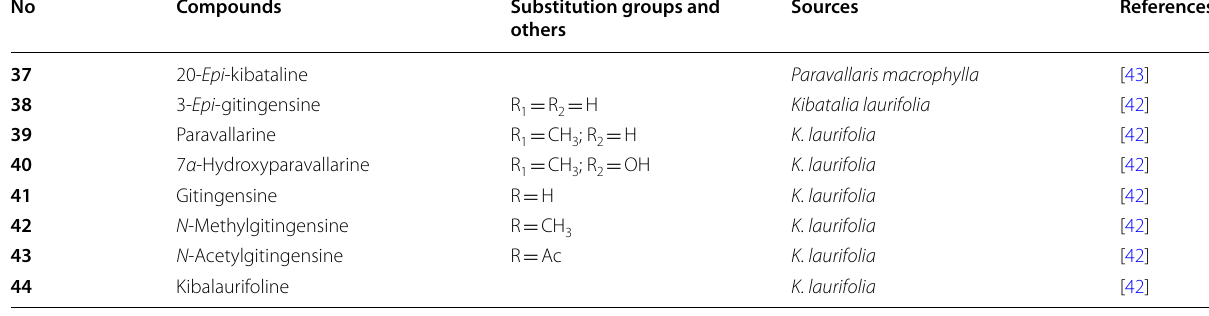
Table 2 Structures and sources of paravallarine type steroidal alkaloids 37–44 Compounds